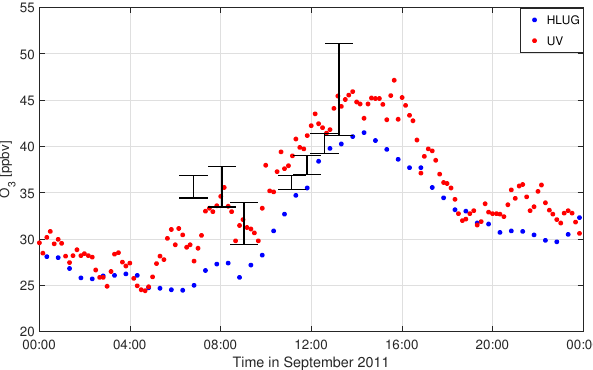
Figure 13. Surface ozone measurements of different instruments at different inlets (HLUG (blue, 30min mean) and UV absorption (red, 10min mean)) on Mount Kleiner Feldberg (825ma . s . l . ), in- cluding the aircraft observations (mean and standard deviation be- tween 1000 to 1600ma . s . l . ) on 6 September 2011.